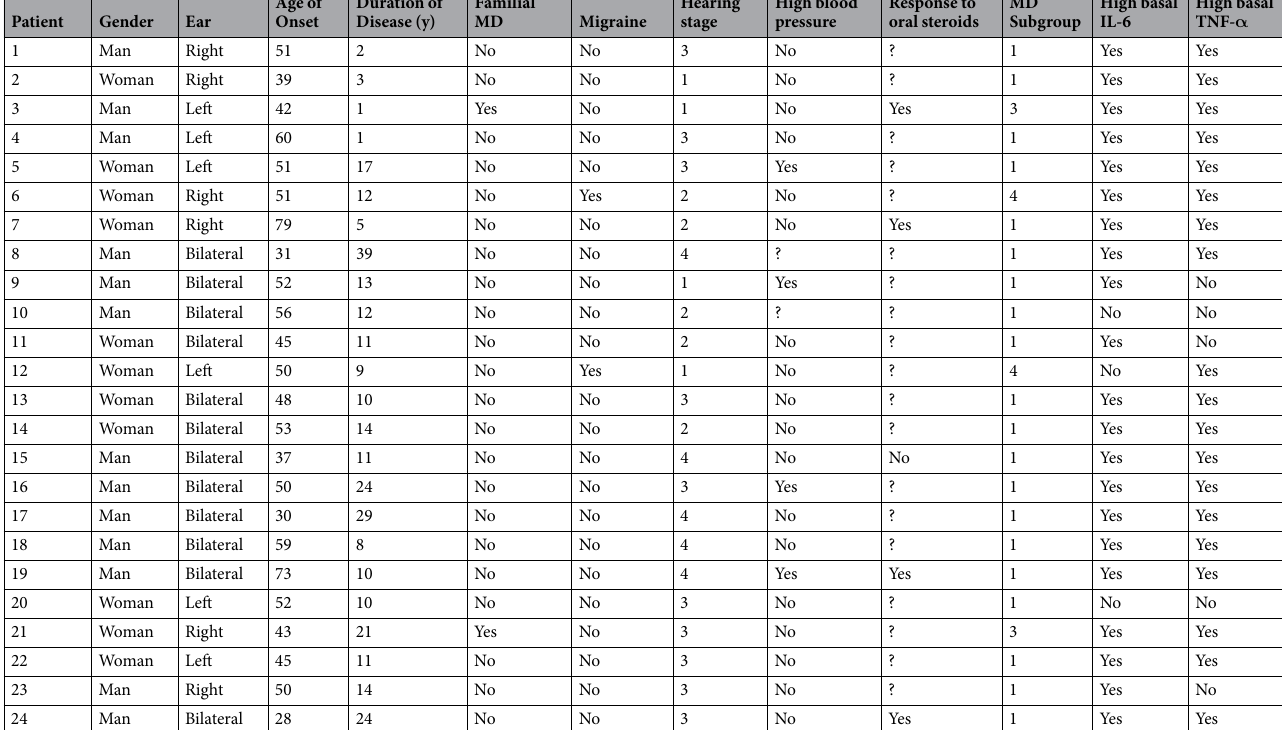
Table 2. Clinical features of 24 patients with MD and elevated proinflammatory cytokines at basal levels. None of the patients have another autoinmune disorder. MD subgroup: 1, unilateral or bilateral disease without migraine, familial history of MD or another comorbid autoinmune condition; 3, familial MD; 4, MD with